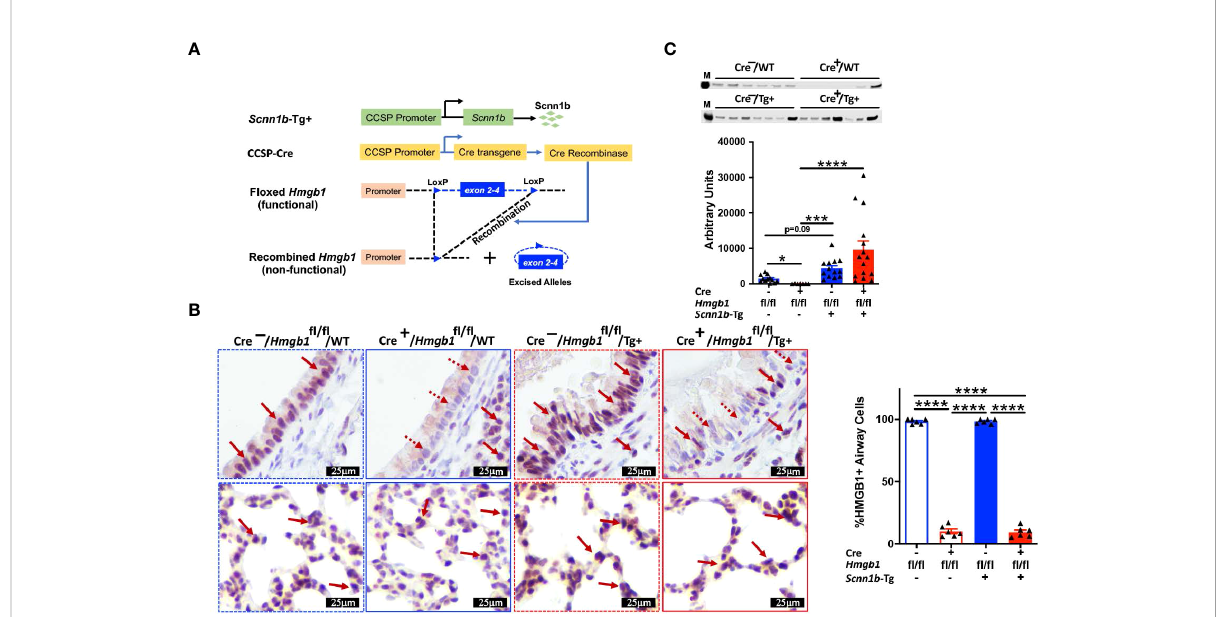
FIGURE 2 Airway epithelial cell-speci fi c deletion of HMGB1. (A) Schematic diagram of transgenes used in the generation of airway epithelial cell-speci fi c HMGB1-de fi cient mice. Airway epithelial cell-speci fi c HMGB1-de fi cient Scnn1b -Tg+ (CCSP-Cre + / Hmgb1 fl / fl /Tg+) mice were generated by crossing club cell-speci fi c Cre recombinase (CCSP-Cre + ), fl oxed Hmgb1 ( Hmgb1 fl / fl ), and Scnn1b -Tg+ mice. (B) Immunohistochemistry for HMGB1 in lung sections from airway epithelial cell-speci fi c HMGB1-suf fi cient and airway epithelial cell-speci fi c HMGB1-de fi cient WT and Tg+ mice. Red solid arrow indicates the HMGB1-stained cells. Red dotted arrow indicates the cells negatively stained for HMGB1. Bar graph shows percent HMGB1-stained cells in the airways. Sample size n=6/group; Error bars represent Mean ± SEM. One-way ANOVA followed by Tukey ’ s post hoc test was used for the statistical analysis. **** p < 0.0001. (C) Western blot showing the depletion of HMGB1 in Cre + / Hmgb1 fl / fl /WT (Cre + /WT) juveniles (red open bar), while comparable HMGB1 between Cre - Hmgb1 fl / fl /Tg+ (Cre - /Tg+) (blue solid bar) and Cre + / Hmgb1 fl / fl /Tg+ (Cre + /WT) (red solid bar) juveniles. Equal volumes of cell-free BALF from all the groups were used as loading samples. M, band from size ladder. Sample size n=7-15/group. Error bars represent Mean ± SEM. One-way ANOVA followed by Tukey ’ s post hoc test was used for the statistical analysis. * p < 0.05, *** p < 0.001, **** p <